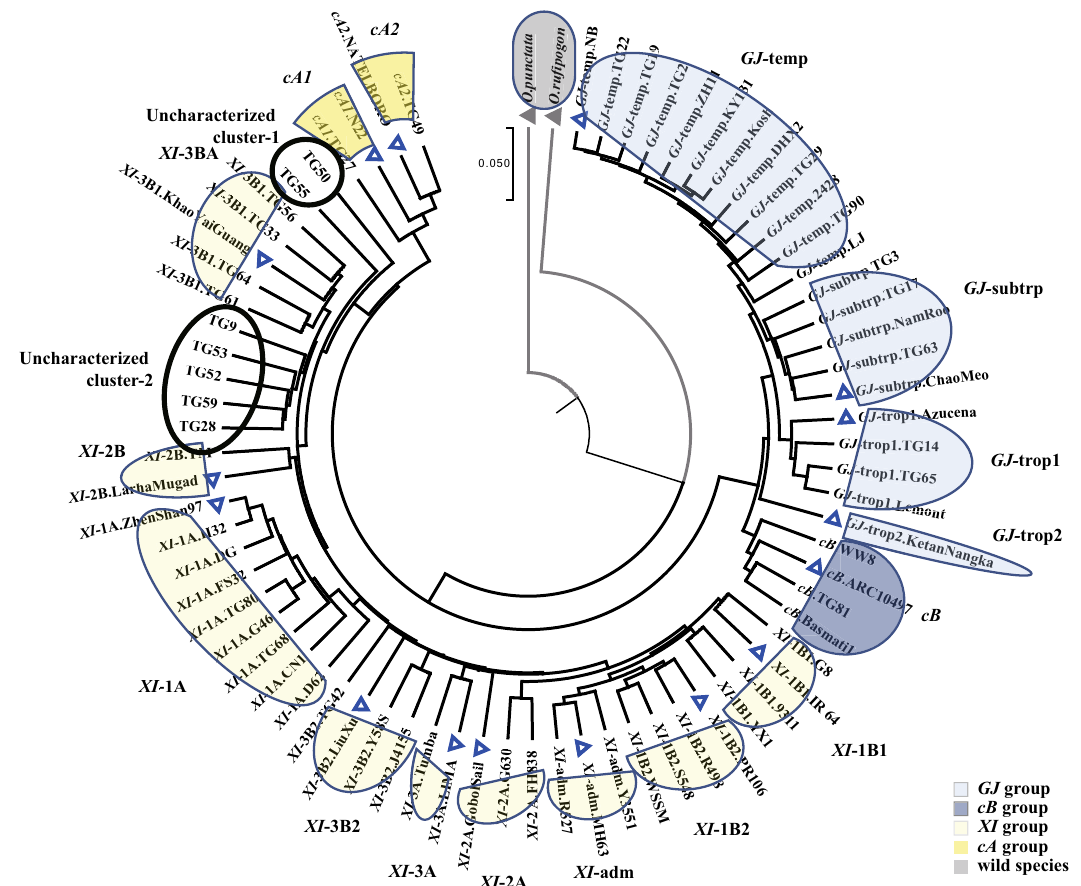
Fig.3|Phylogenetictreeof75high-qualityricegenomesusingthepan-genome inversionindex. Phylogeneticrelationshipsofthe75high-qualitygenomesusedto create the pan-genome inversion index, inferred using the UPGMA method (unweightedpairgroupmethodwitharithmeticmean 95 ).Thetreeisdrawntoscale, withbranchlengthsinthesameunitsasthoseoftheevolutionarydistancesusedto inferthephylogenetictree.EvolutionaryanalyseswereconductedinMEGA7 96 .Two